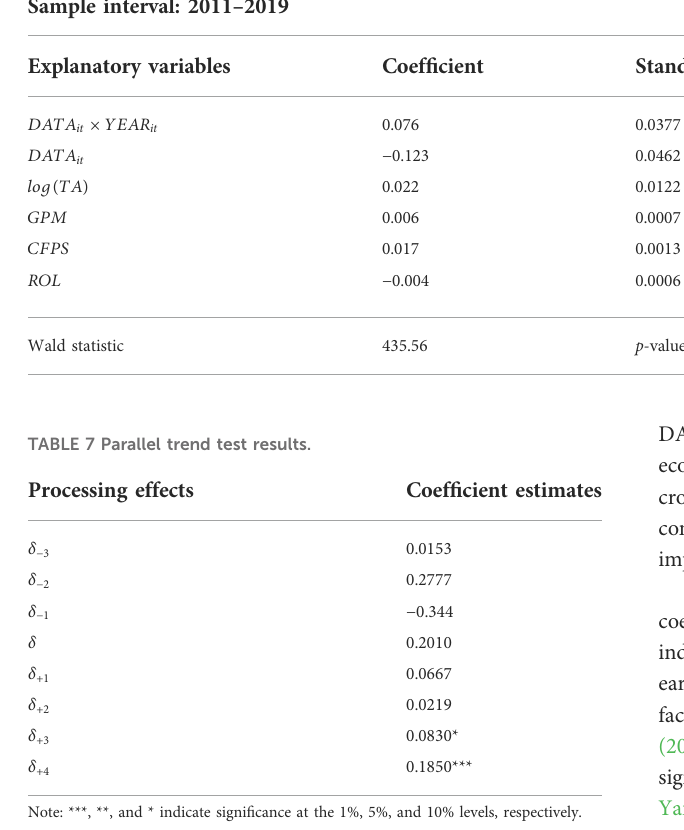
TABLE 6 Baseline model results.